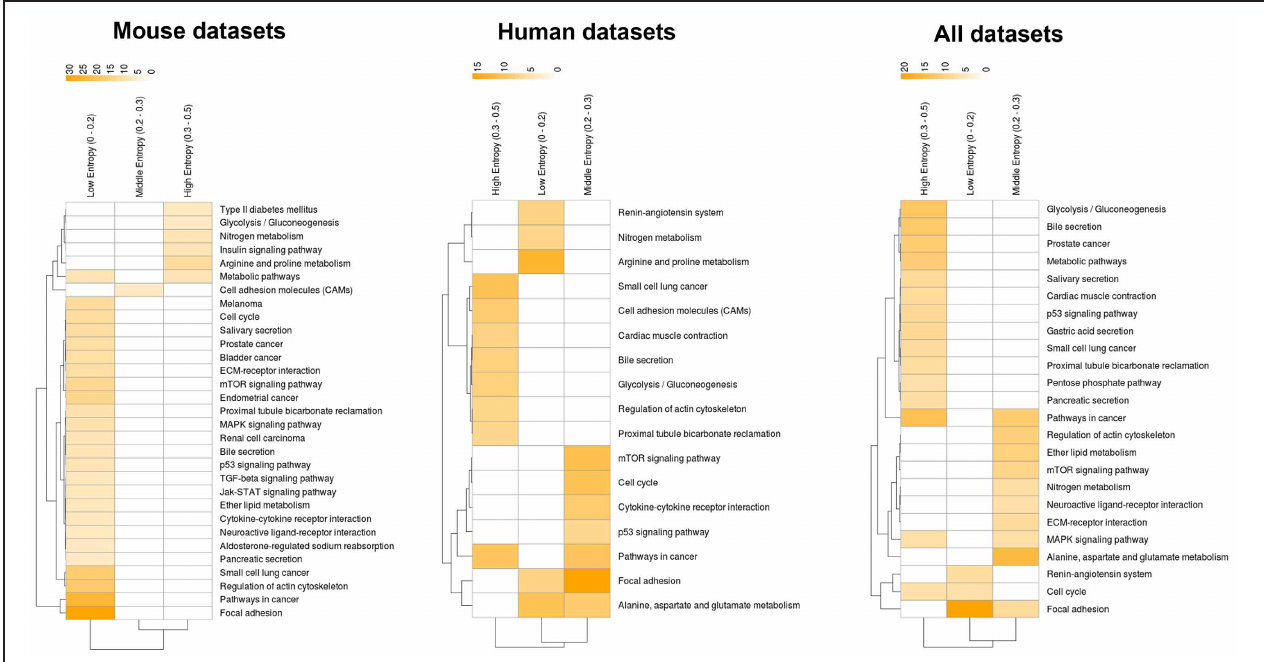
FIGURE 3 | Heat-maps illustrating the biological content of FOXO3 target genes as a function of gene entropy values. Biological content is inferred using enrichment in KEGG pathways ( P < 0 . 001) for